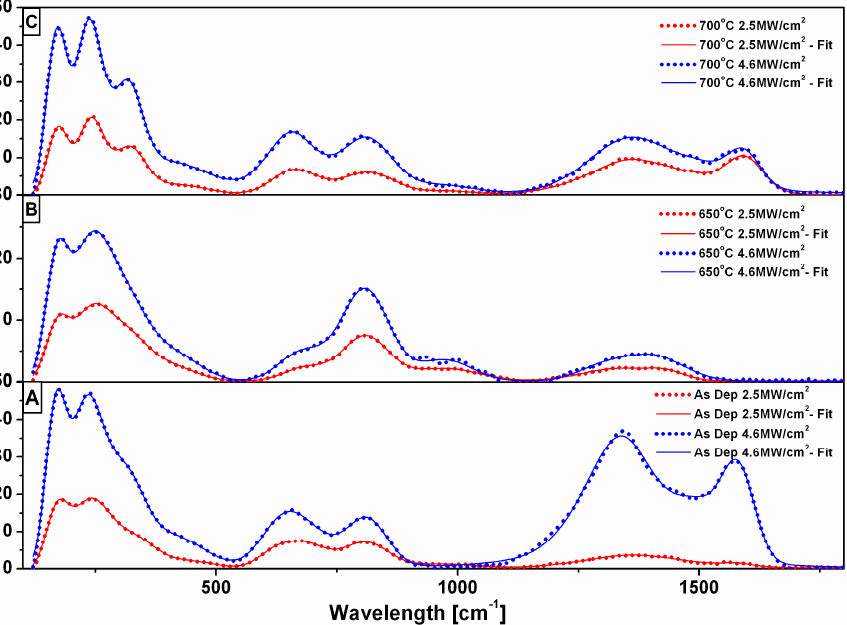
Figure 4. Raman spectra for sample no.1 at two different laser power values: 2.5 and 4.6 MW/cm 2 , respectively. ( A ) As-deposited, ( B ) annealed at 650 °C for 30 min, and ( C ) annealed at 700 °C for 30 min. Experimental data are represented by dots, while the data fitting is represented by the continuous line.